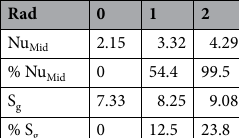
Table 5. The average Nu and total generated entropy for dissimilar radiation parameters at φ = 0.3, λ = 0°, Ra = 10 5 , γ = 45°, Ha = 20.